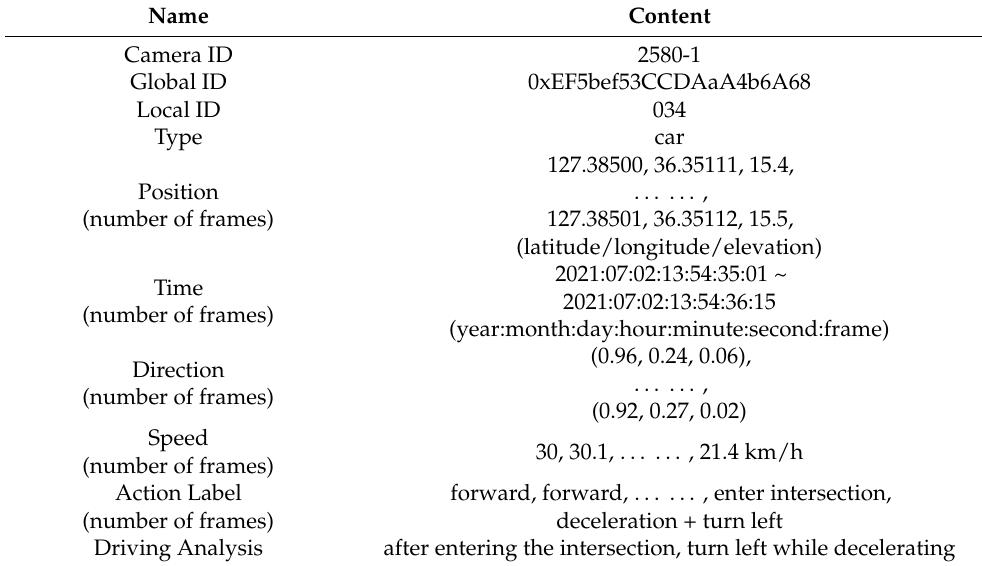
Table 3. An example of individual mobility object analysis